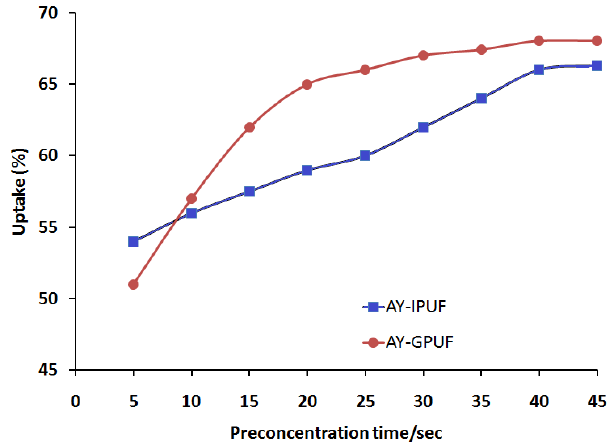
FIGURE 15 - Effect of preconcentration time on the uptake of